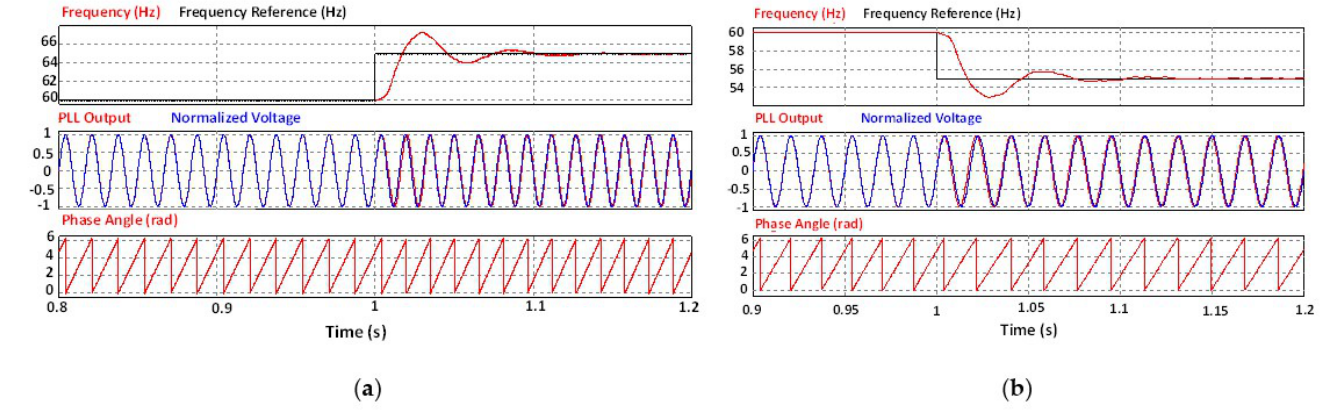
Figure 14. Frequency, PLL Output, and Voltage Phase ( a ) after a positive 5 Hz frequency step; ( b ) after a negative 5 Hz frequency step.